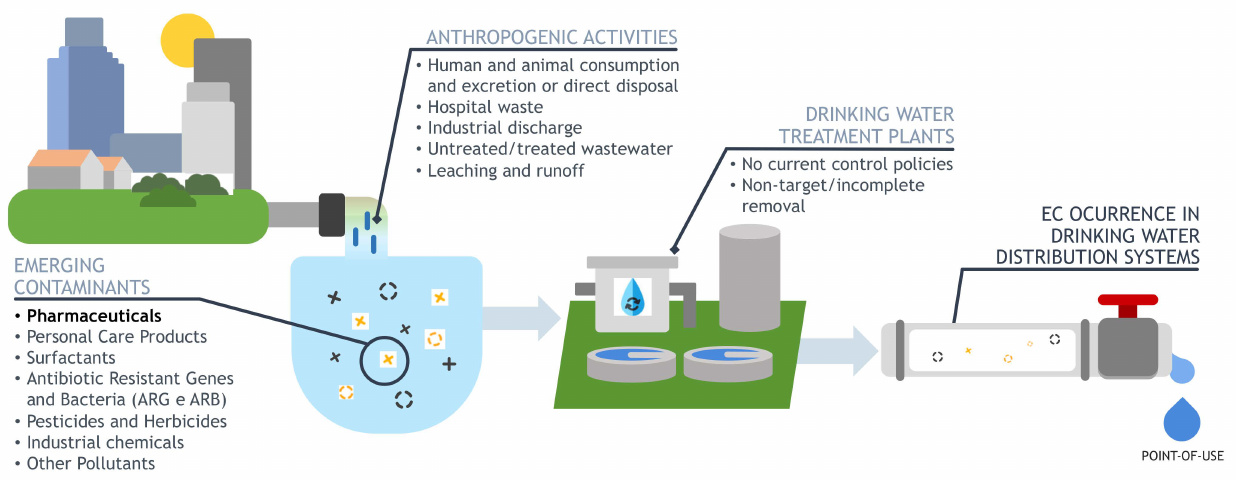
Figure 2. Overview of ECs sources and transport to point-of-use: Anthropogenic activities (coming from human and animal consumption and excretion; hospital waste; industrial discharge; untreated or inefficiently treated wastewater; direct disposal; landfill leaching; agricultural activities; runoff [43,44]) are the main sources of emission of these pollutants, that are not currently monitored and are usually detected at trace level concentrations in the environment. Contaminated water resources are the source of EC presence in DW, as the equipment used in WTPs does not remove these contaminants and results in treated water being redirected to DWDS. Finally, the consumer is exposed to